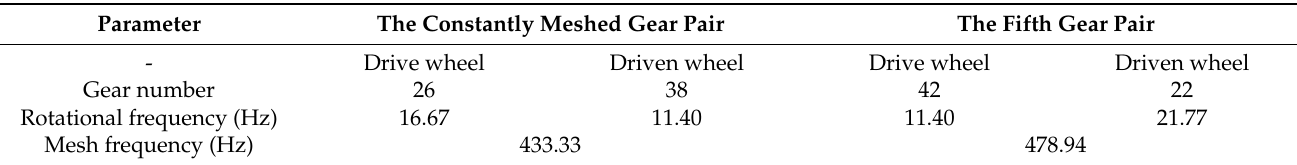
Figure 13. The five-speed transmission test bench: ( a ) The five-speed transmission; ( b ) Drive struc- tural diagram; ( c ) The local fault gear with broken tooth. Table 4. The operating parameter of the